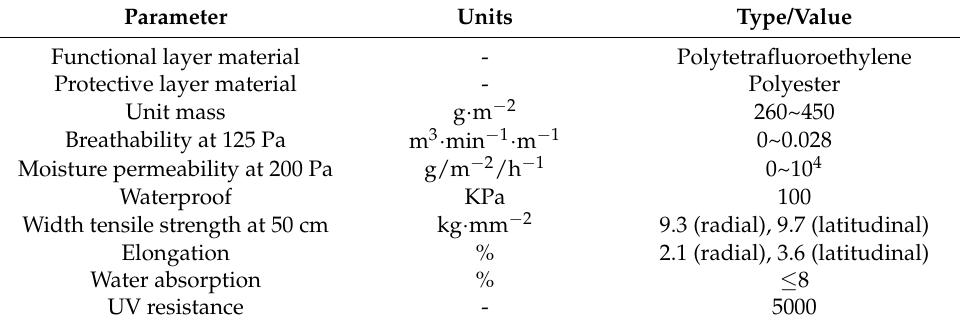
Figure 1. Schematic diagram of the structure of semi-membrane covering aerobic composting system ( a ), the real composting conditions ( b ), and the sample points ( c ). Notes for ( a ): 1. Hardened Ground; 2. Drainage Ditch; 3. Aeration Pipeline; 4. Compost Piles; 5. Functional Membrane; 6. Testing Sensors (Temperature, Oxygen, Pressure); 7. Control System; 8. Membrane Sealing. Table 1. Composting membrane performance parameter.